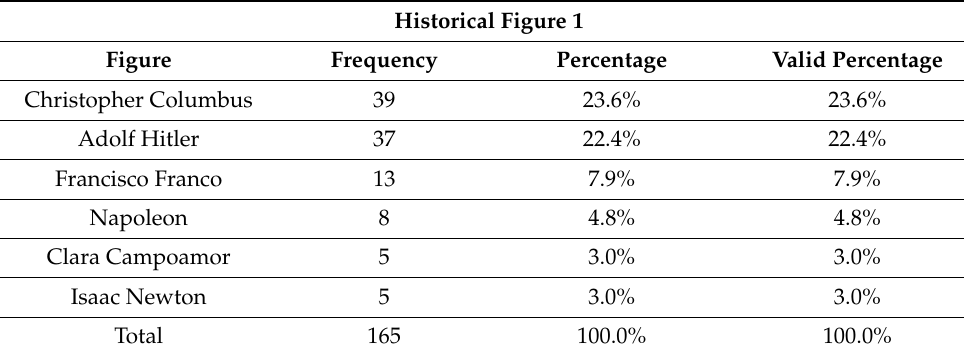
Table 2. First historical figure chosen by